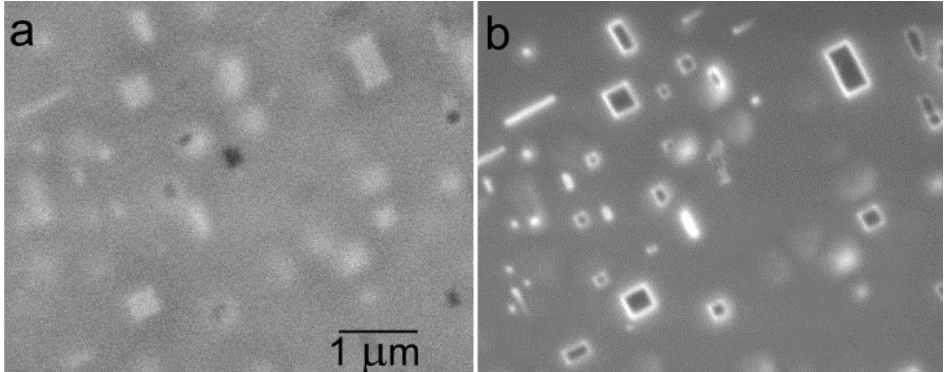
Si with 0.4% excess Mg alloy, heated for Figure 7. Precipitates in the Al-1.0 mass% Mg 2 60 min at 848 K, quenched in chilled water and age-hardened for 60 min at 673 K. ( a ) Standard BSE image obtained at 10 keV with a below-OL coaxial detector; ( b ) Sample immersed in 1.2 kV/mm field, landing energy 1500